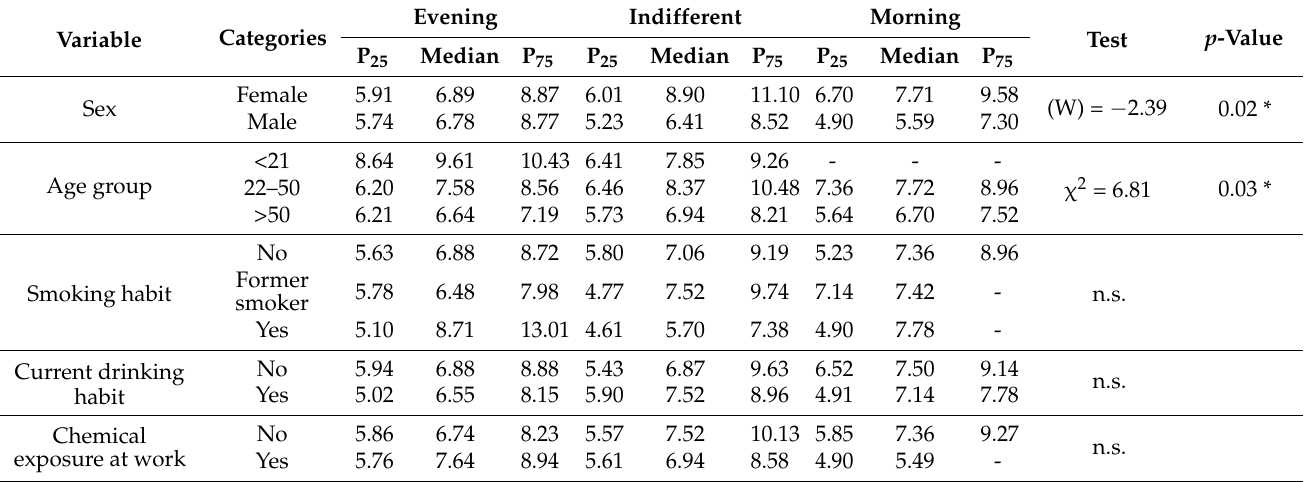
Table 5. Manganese in blood ( µ g L − 1 ) according to PER3 gene VNTR polymorphisms stratified by sex, age group, smoking and drinking habits, and chemical exposure at